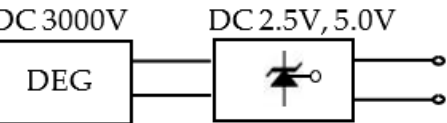
Figure 13. Shunt regulator circuit with TI reference voltage IC (2.5 V, 5 V output).